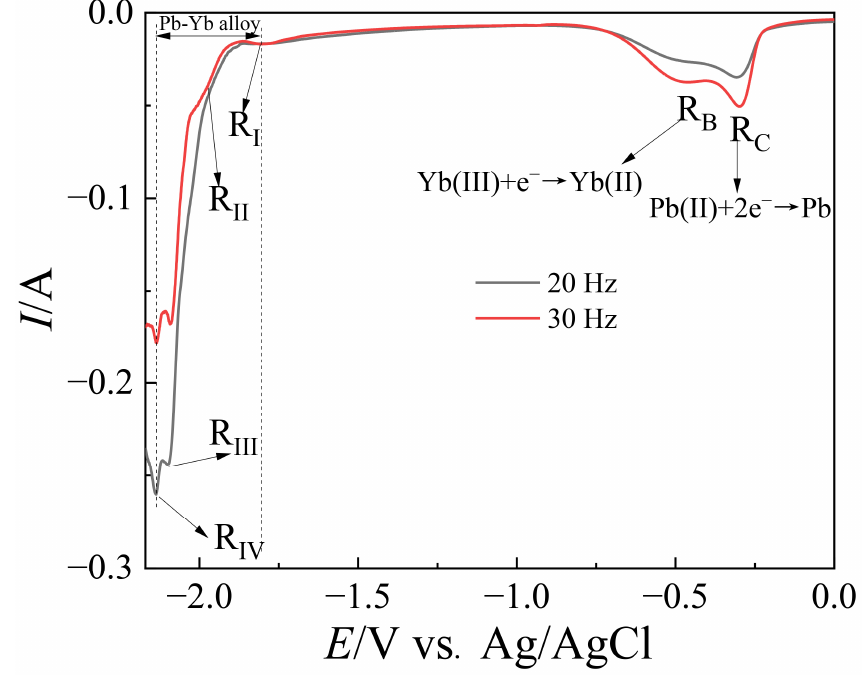
Figure 8. SWV curves of molten LiCl-KCl-YbCl 3 -PbCl 2 on the W electrode at 773 K under different frequencies; potential step: 5 mV; frequency: 20-30 Hz. Table 2. Summary of the results obtained on a Pb film electrode through CV, SWV, and OCP in molten LiCl-KCl-YbCl 3 .